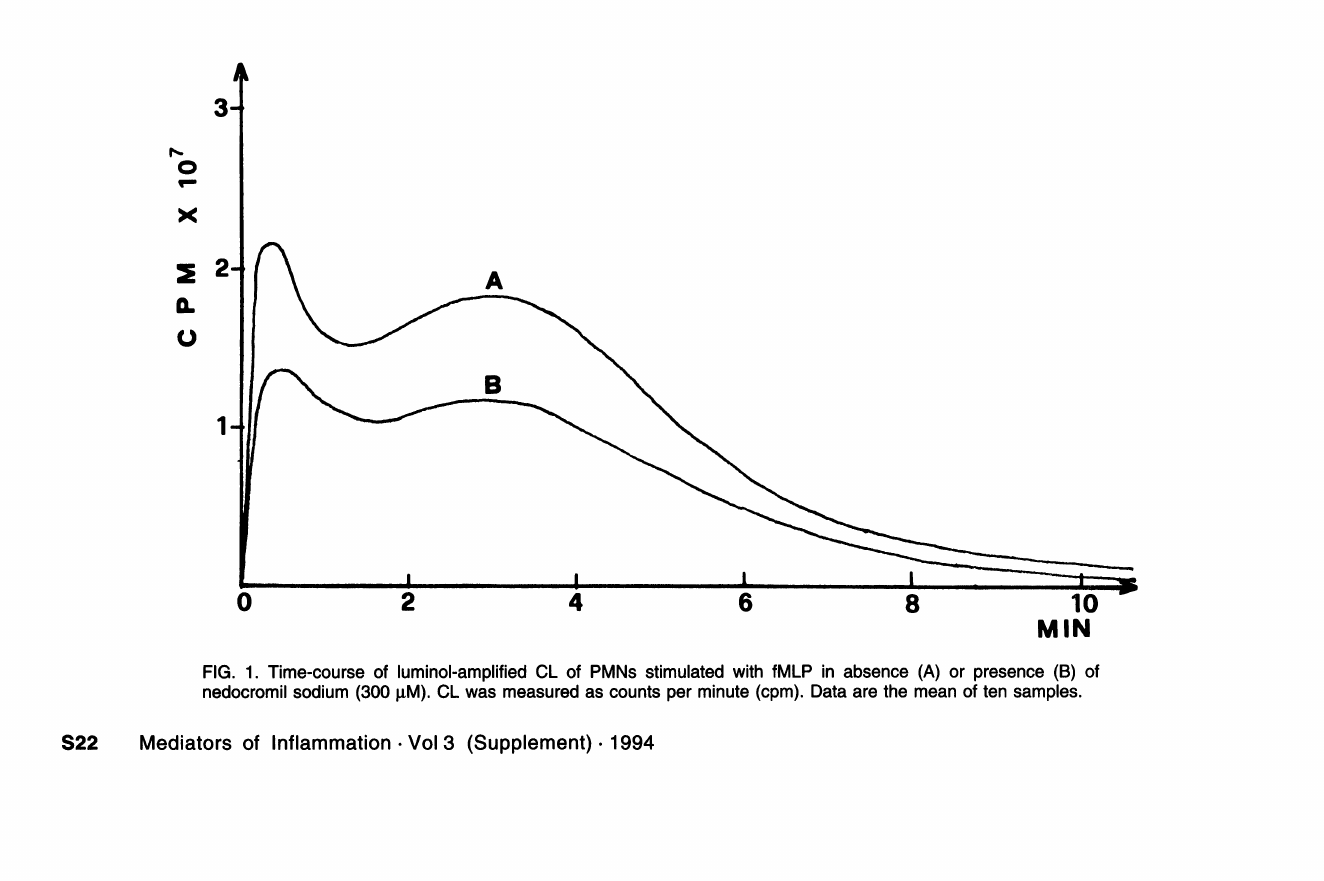
FIG. 1. Time-course of luminol-amplified CL of PMNs stimulated with fMLP in absence (A) or presence (B) of nedocromil sodium (300 IM). CL was measured as counts per minute (cpm). Data are the mean of ten samples. S22 Mediators of Inflammation. Vo13 (Supplement).